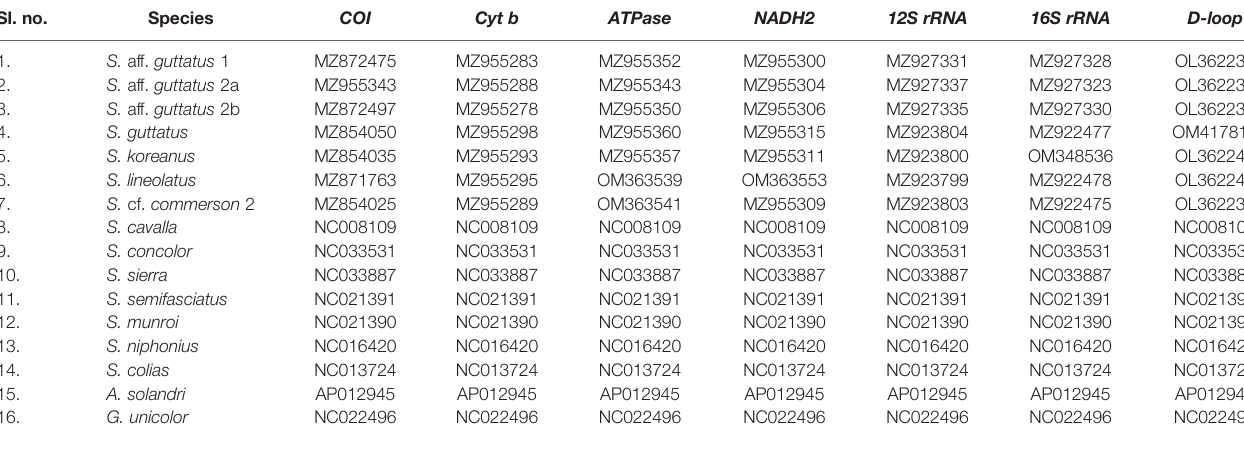
algorithm 1 with fi ne-tuning parameter epsilon = 2 and